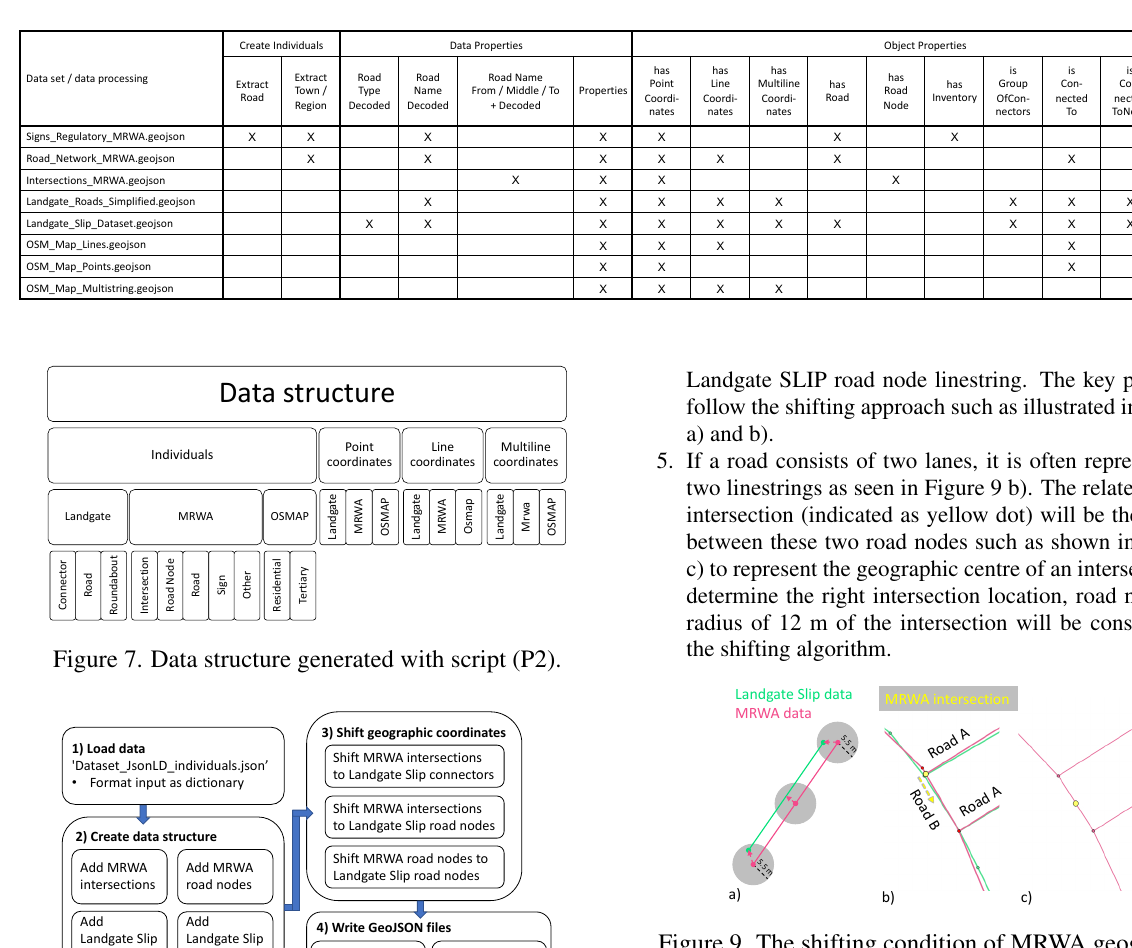
Table 1. Representation of the Python script (P1) functionality for the MRWA, Landgate and OSMAP data sets. This script creates individuals, writes data properties and allocates object properties. The results are written as RDF/Turtle files for each data source.